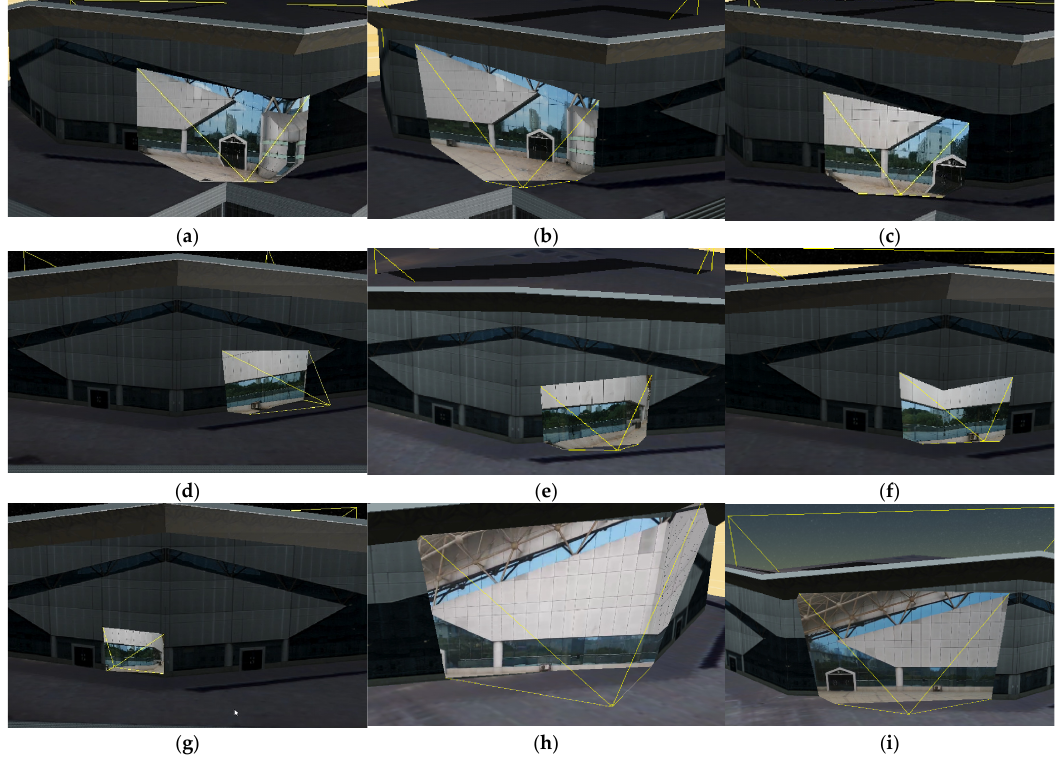
Figure 11. Experimental results of dynamic projection texture mapping at different moments. ( a – i ) show the dynamic fusion results in chronological order for the different views. In order to visually detect the homonymous feature points, Figure 12 turns down the transparency of the projected video so that the texture of the video and the texture of the model can be seen at the same time. By measuring the texture deviation of the homony- mous points, the error of the dynamic projection is larger compared to the static projec- tion. The error of the view cone midline is only affected by the error of the pitch and yaw angles and is centered on the midline; the further away from the midline, the more the fragment is affected by the roll angle error (see the red box on the left side of the projection in Figure 12b,c). At the same time, the deviation of image fusion is also affected by the projection depth, i.e., the farther the fragment is from the viewpoint and the deeper it is projected, the relatively larger the Euler angular error it suffers (see the blue boxes on the right side of plots a, b, and c and on the left side of the projection of plot d). By measuring the deviation of the same name point, the projection error of the apparent center line is around ±1 m. In the video edge slice element, where the relative error is large, the error is between 2 and 3 m. The error contains not only the Euler angle solution error, but also GPS positioning error, timing correspondence error, and related model error.